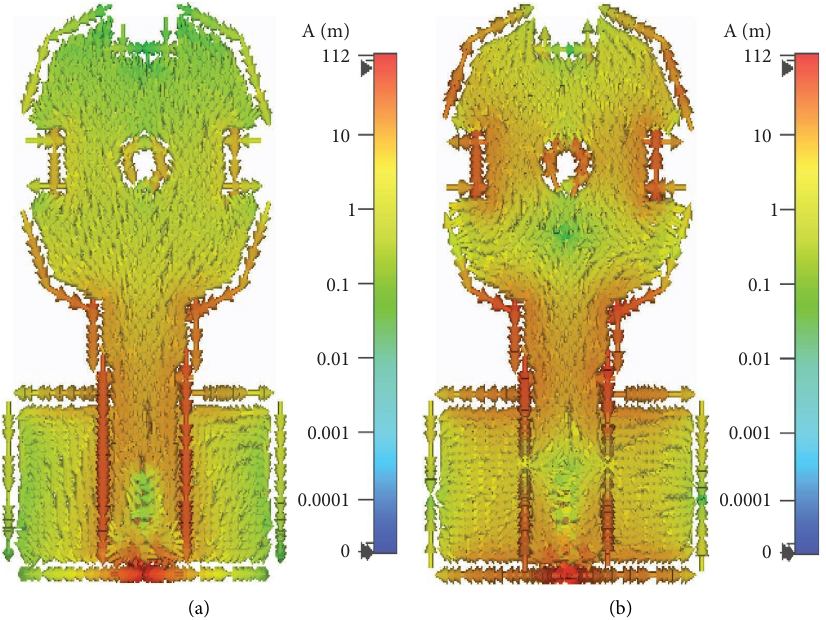
Figure 4: Current distribution at (a) 4 GHz and (b) 10GHz.